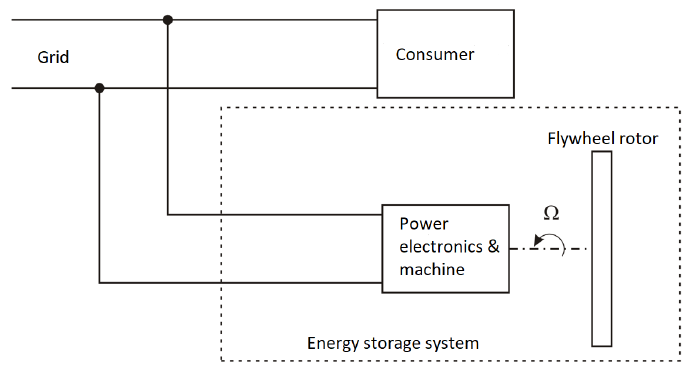
Figure 1. Typical daily power and energy consumptions.